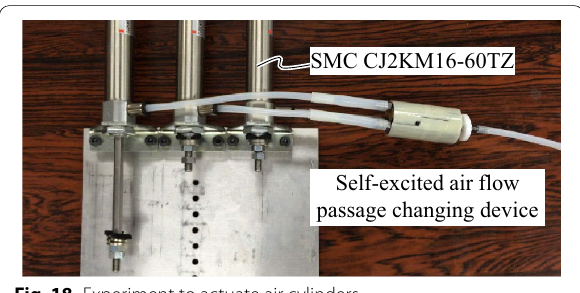
Fig. 18 Experiment to actuate air cylinders